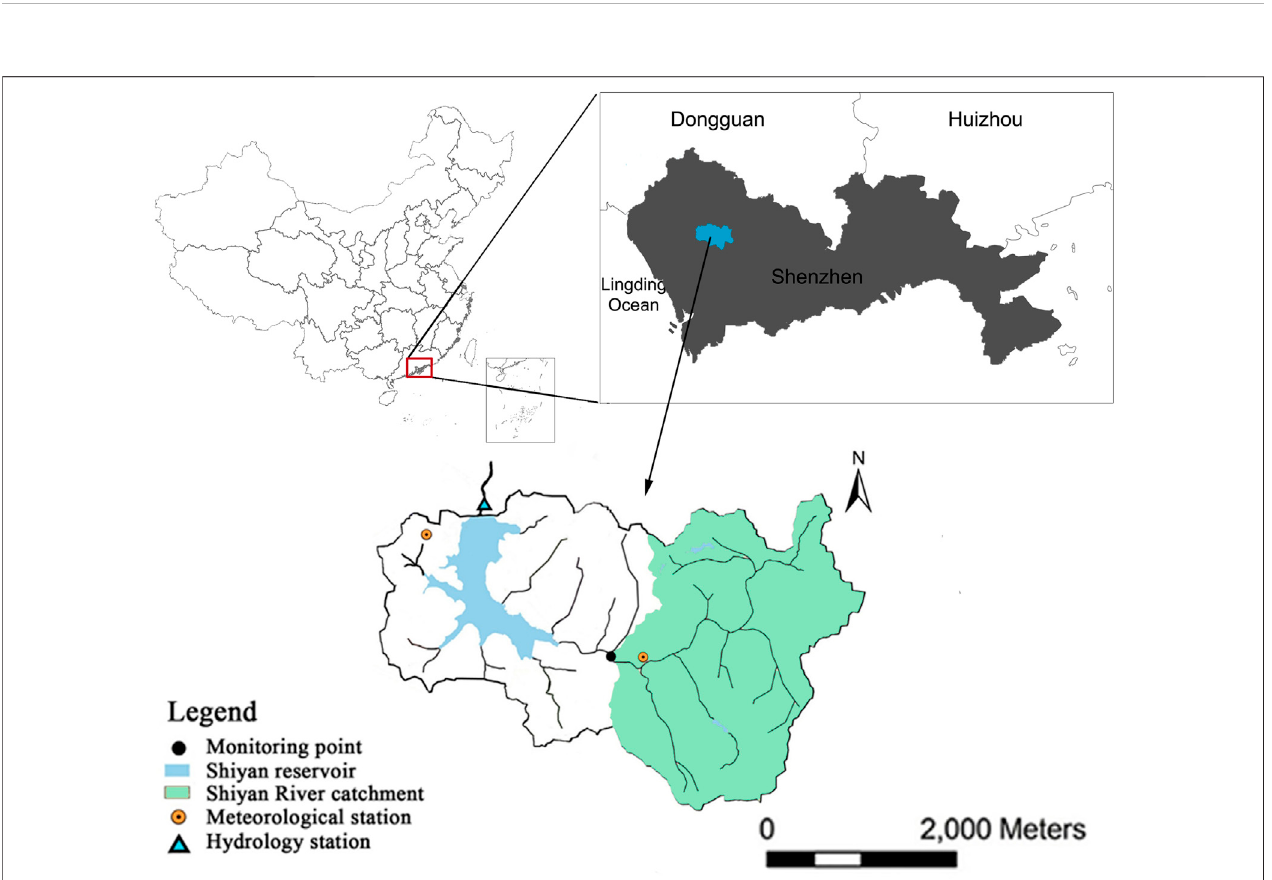
FIGURE 1 | Map of Shiyan River, Shenzhen,